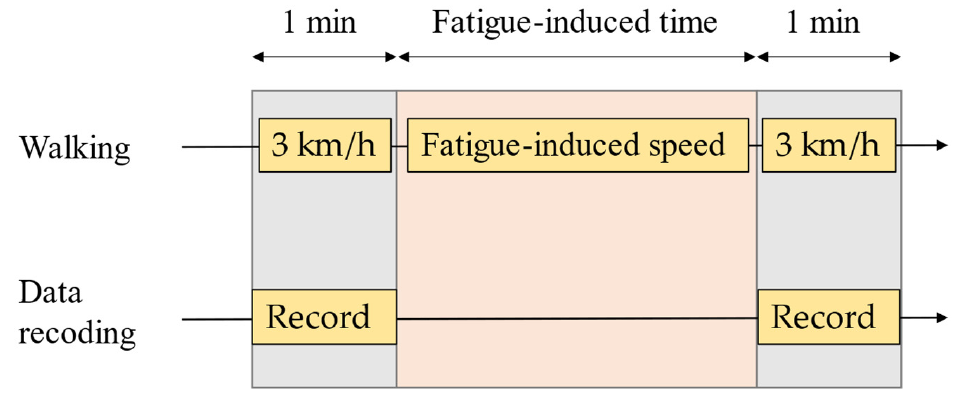
Figure 8. Procedure of the main experiment.